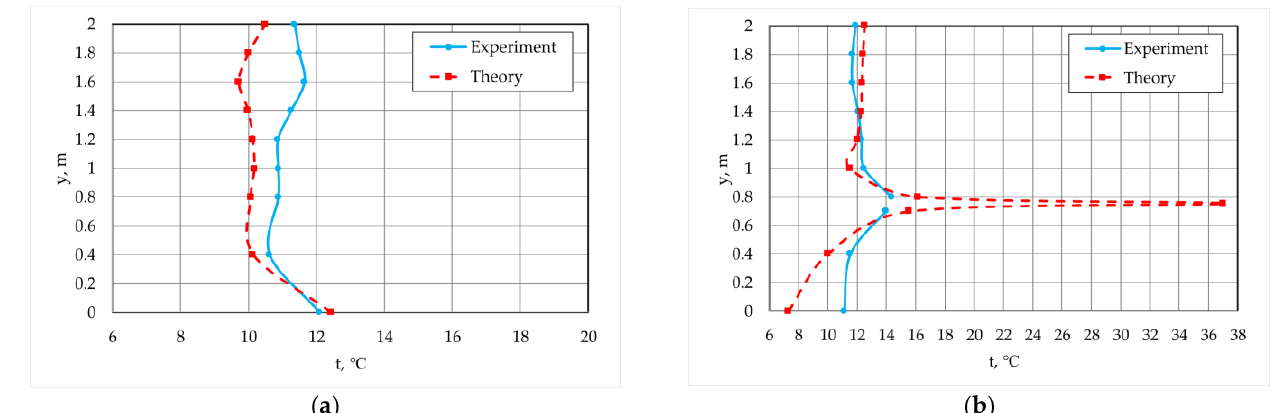
Figure 9. Distribution of experimental and theoretical values of air temperatures along the Y coor- dinate on the GIH symmetry axis ( τ = 60 min): ( a ) premises without the panel, and ( b ) with a 0.755 m high panel.